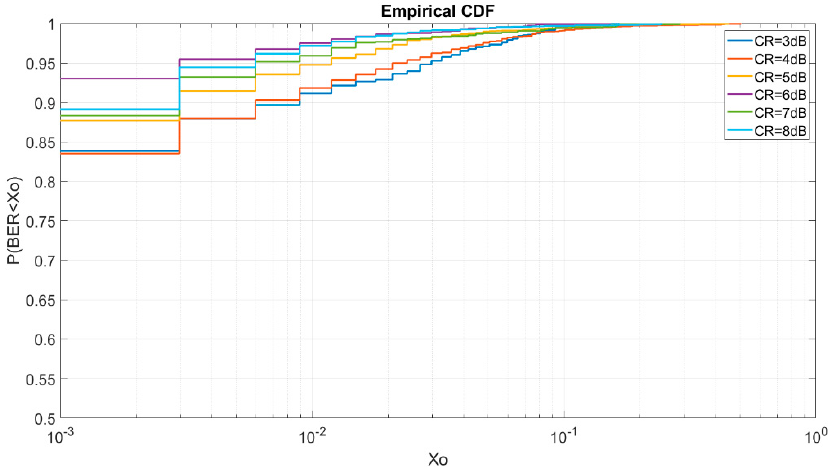
Figure 10. 25 W SC-FDE CR sweep CDF.